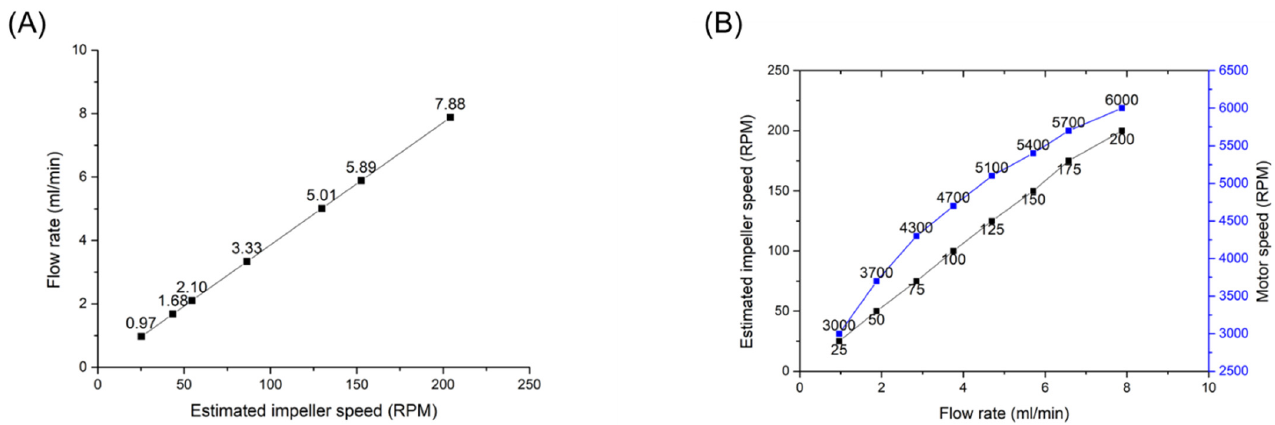
Figure 7. A flow rate curve according to an estimated impeller speed ( A ) and speed of the impeller and the motor according to the flow rate ( B ). and the motor according to the flow rate ( B